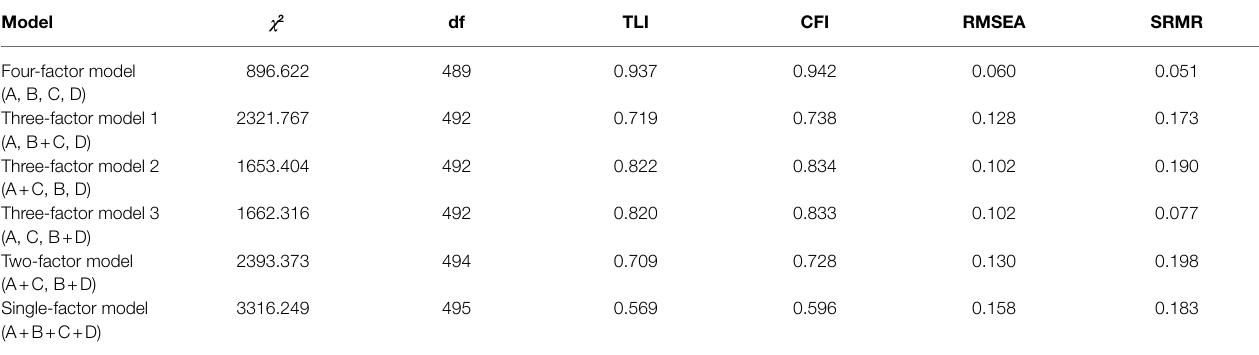
A, negative workplace gossip; B, workplace exclusion; C, differential atmosphere perception; and D, employee organizational self-esteem.